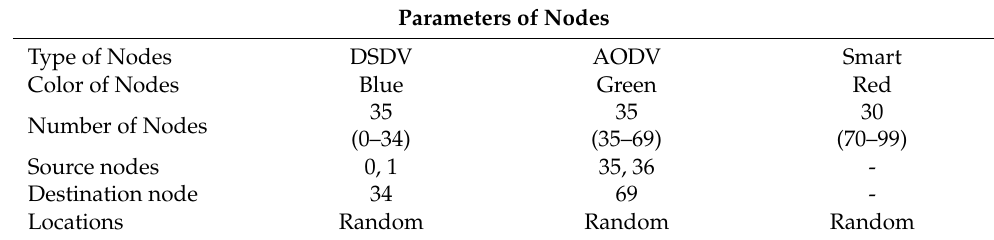
Table 10. Case 2: Parameters for classes of nodes.